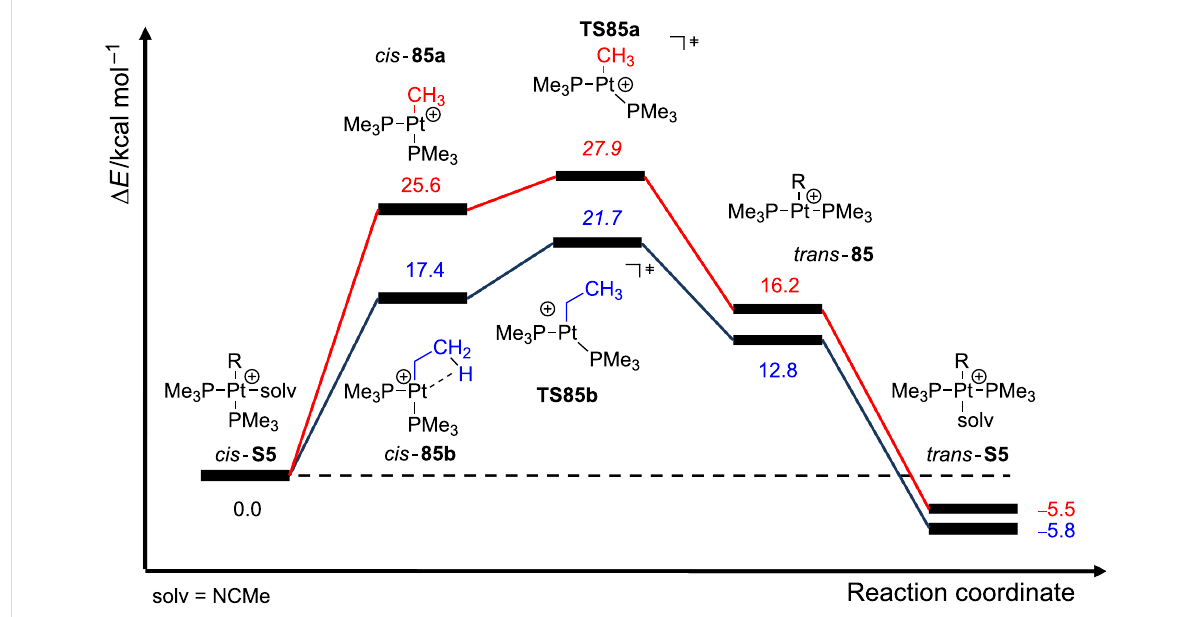
Figure 20: Energy profiles for the isomerization of complexes [Pt(R)(PMe 3 ) 2 (NCMe)] + where R means Me ( 85a , red line) and Et ( 85b , blue line) [2].